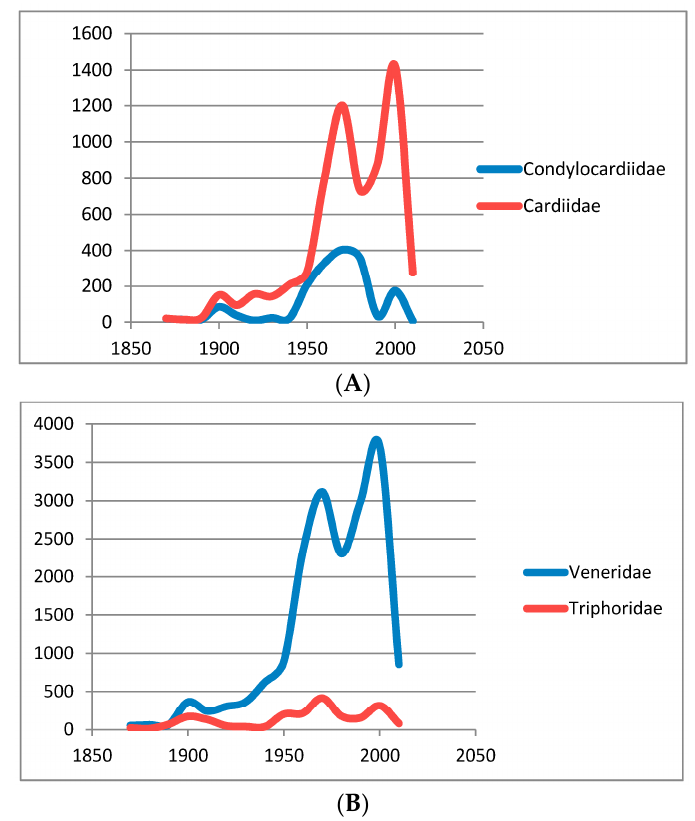
Figure 3. A micromollusc bias. ( A ) Comparison of Condylocardiidae and Cardiidae collection activity per decade in Australia; and ( B ) comparison of Veneridae and Triphoridae collection activity per decade in Australia [14].